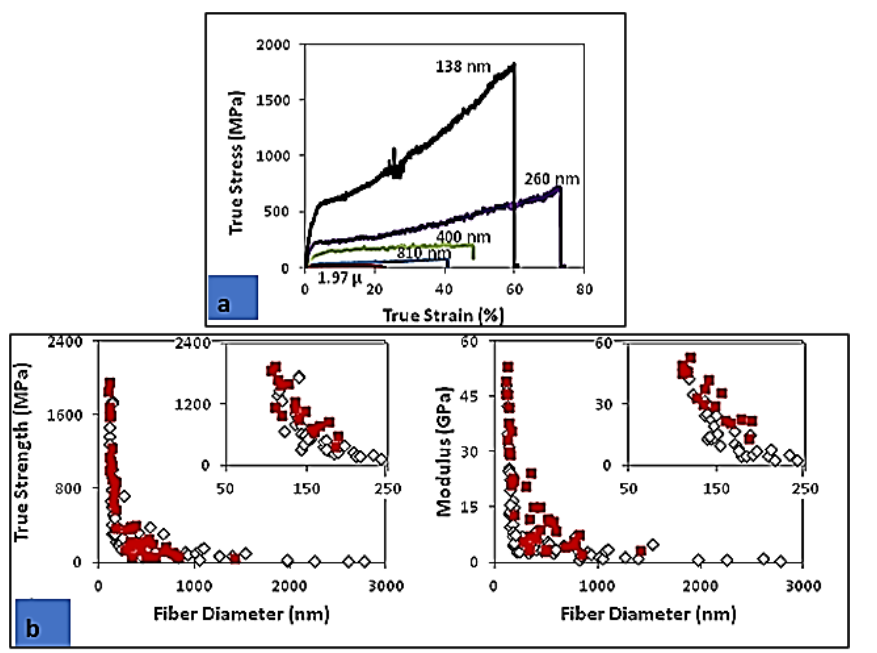
Figure 8. ( a ) Stress–strain graph of as-spun polyacrylonitrile (PAN) nanofibers. ( b ) Strength and modulus of annealed nanofibers. (Reprinted with permission from Reference [ 140 ] . Copyright (2004) American Chemical Society.)